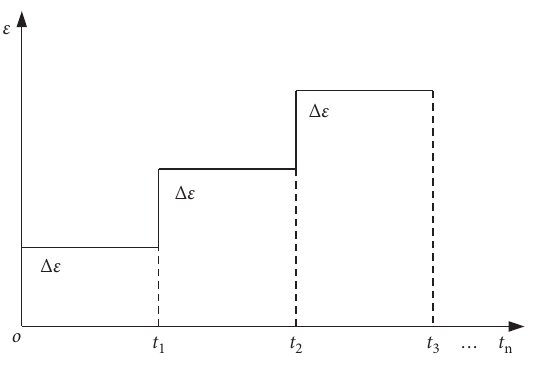
Figure 5: Loading process of relaxation test.